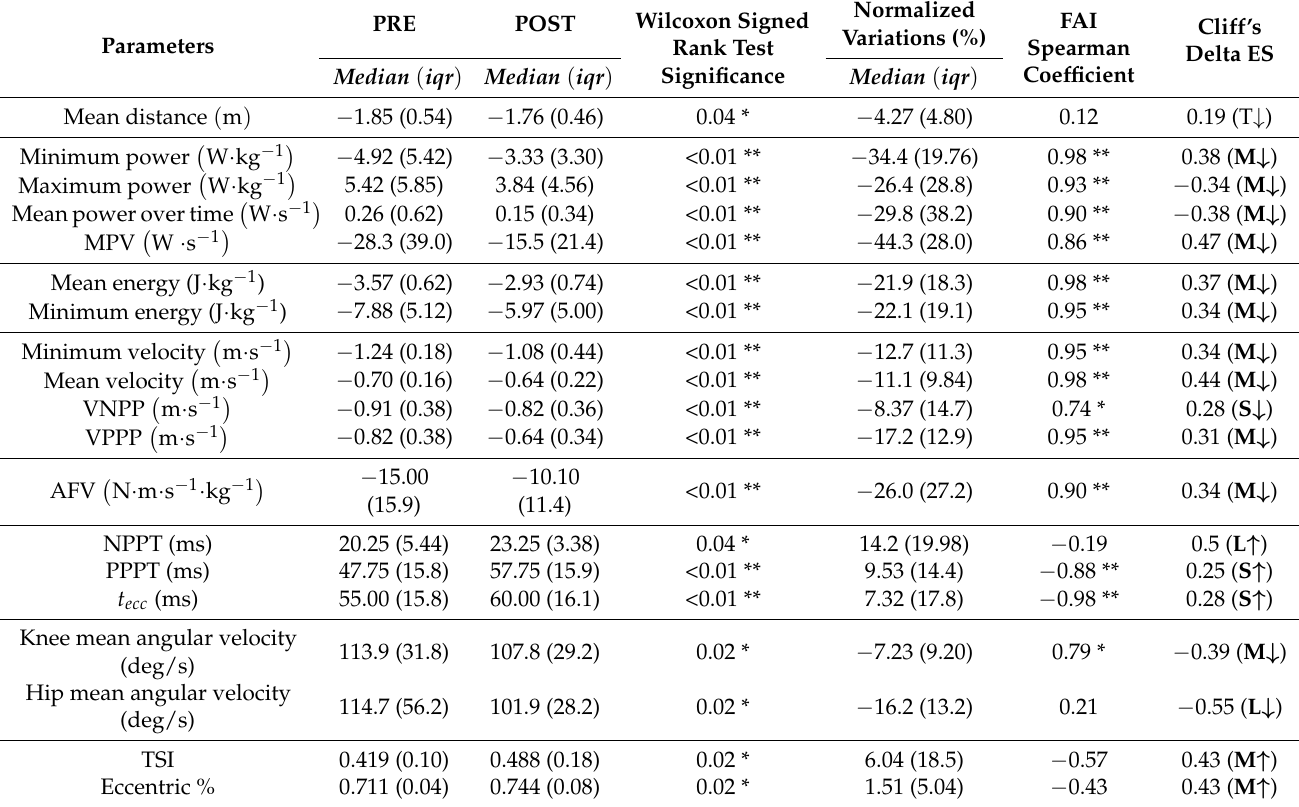
Figure 5. Normalized variations for all the parameters of the fatigued group. MPV = mean power velocity, VNPP = velocity at negative power peak, VPPP = velocity at positive power peak, AFV = area under the force-velocity curve, NPPT = negative power peak time, PPPT = positive power peak time, TSI = temporal symmetry index. Table 2. Kinematic parameters (fatigued